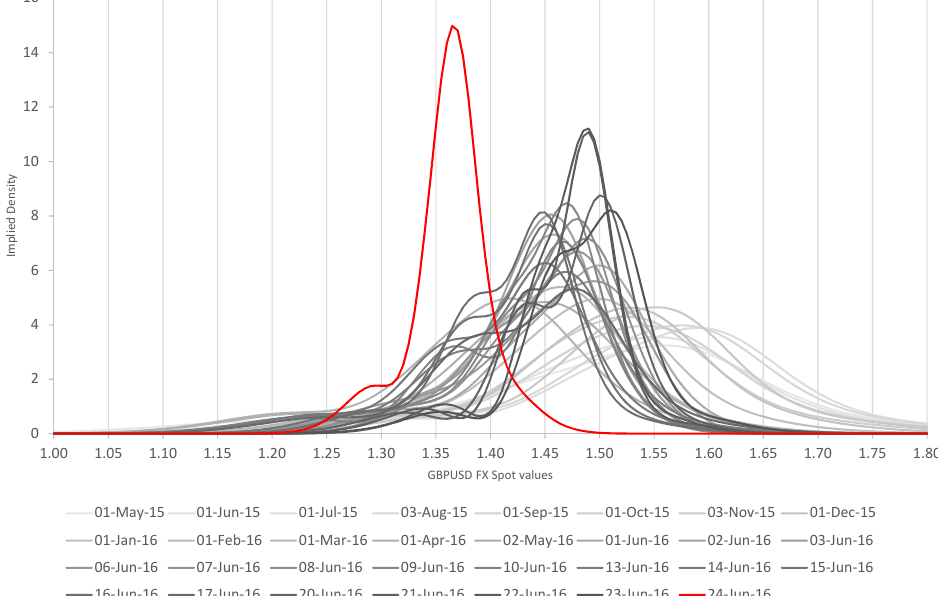
Figure 3. GBPUSD implied densities for the Brexit referendum date from 1 May 2015 to 23 June 2016, sampled monthly from 1 May 2015 to 1 June 2016, then sampled daily (in grey/black), and for the next business day on 24 June 2016 (in